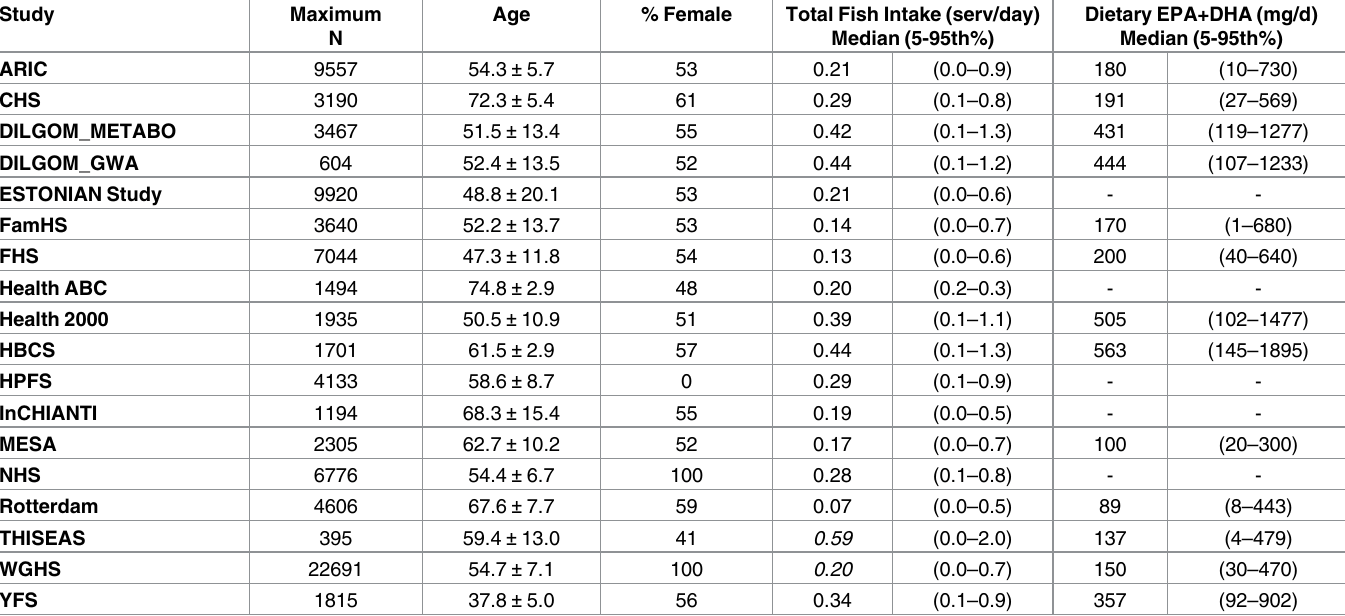
Table 1. Characteristics of the cohorts included in this analysis of the genetics of fish